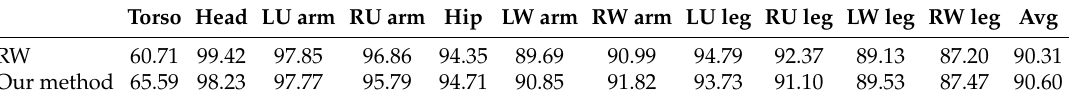
Table 6. Dataset 2 [5]: mean per-class accuracy in % over all frames.